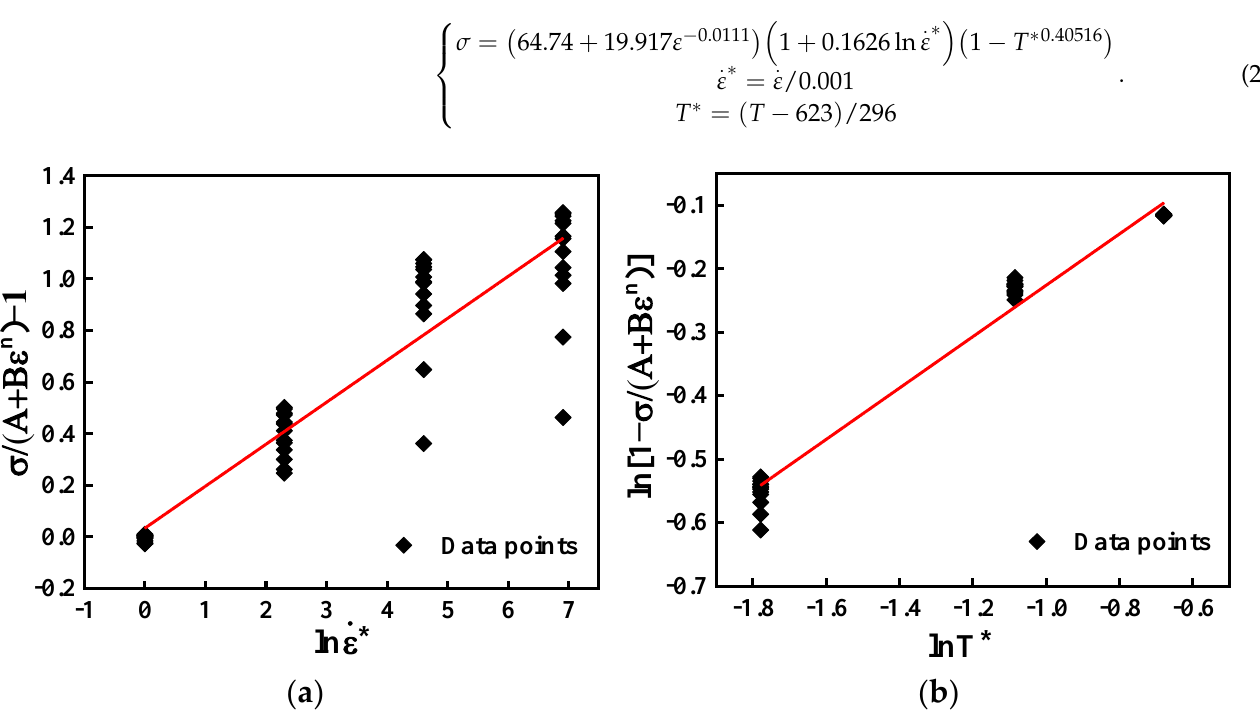
. ∗ ε ; ( b ) ln [ 1 − σ / ( A + B ε n )] and ln T ∗